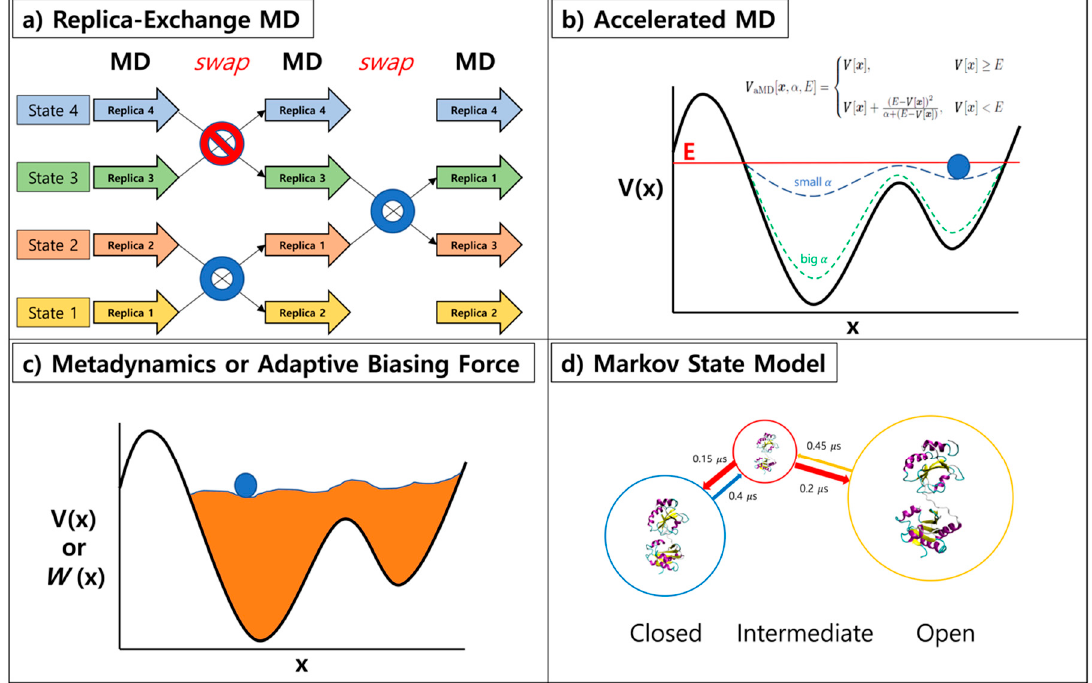
Figure 2. Overview of enhanced sampling methods: ( a ) replica-exchange MD simulation, ( b )